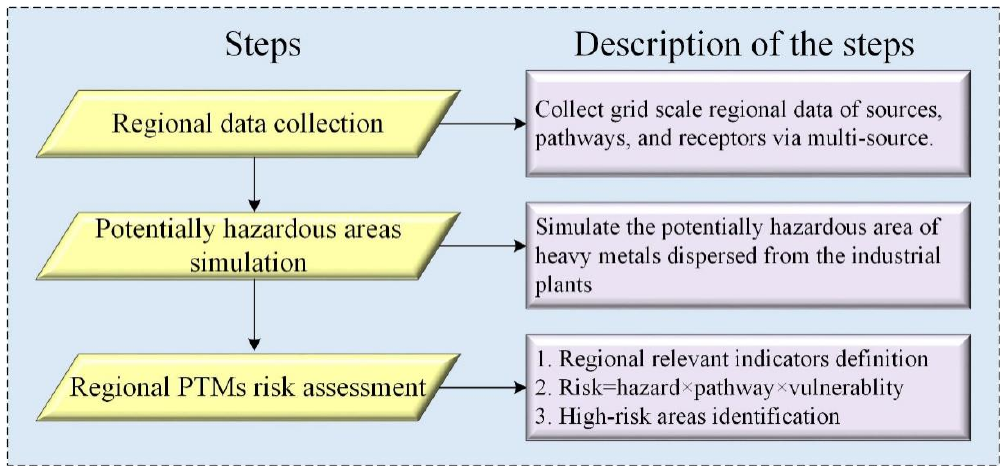
Figure 2. Framework of the proposed regional risk assessment of potentially toxic metals (PTMs).